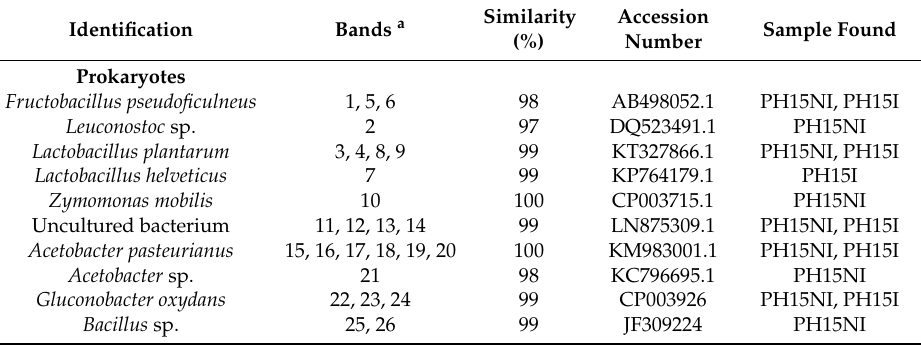
Table 1. Identification of the bands based on Basic Local Alignment Search Tool (BLAST) in comparison with those in GenBank as obtained by PCR–DGGE using universal primers for yeasts and